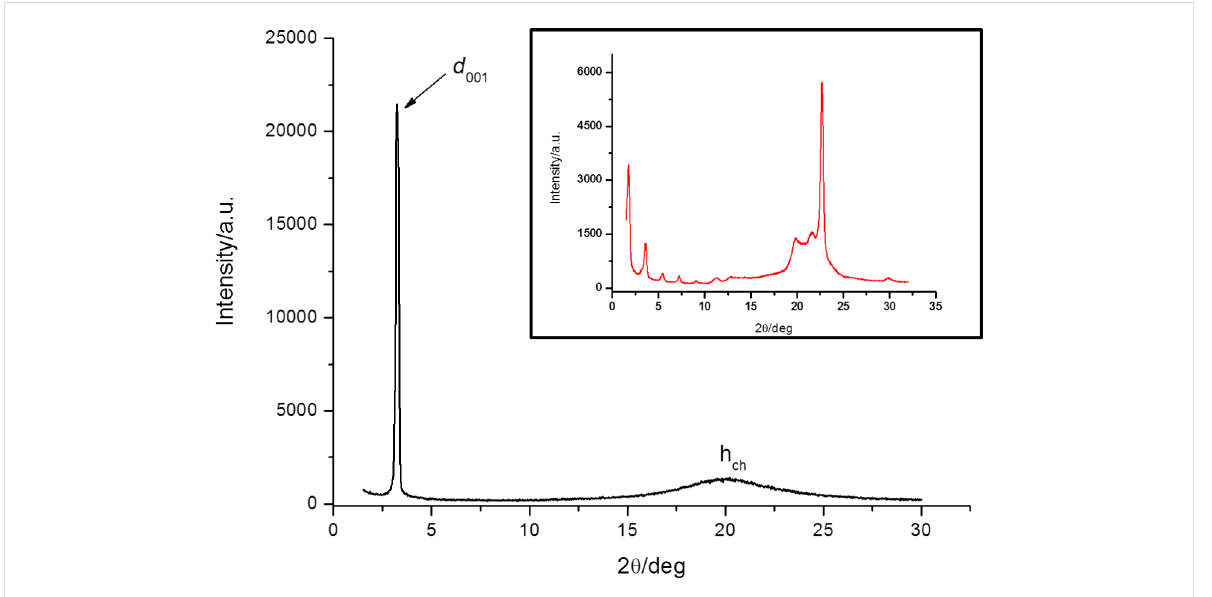
Figure 4: Powder XRD pattern of [bisC 8 ImC 10 ][C 12 H 25 OSO 3 ] 2 recorded at 298 K, after cooling from the isotropic state. Inset: the XRD pattern re- corded at 298 K in the crystalline state (prior to heating).